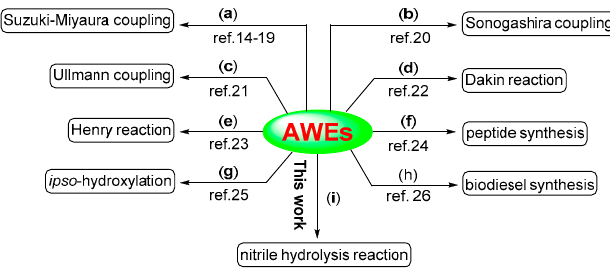
Scheme 1. Representative reactions realized in AWEs.